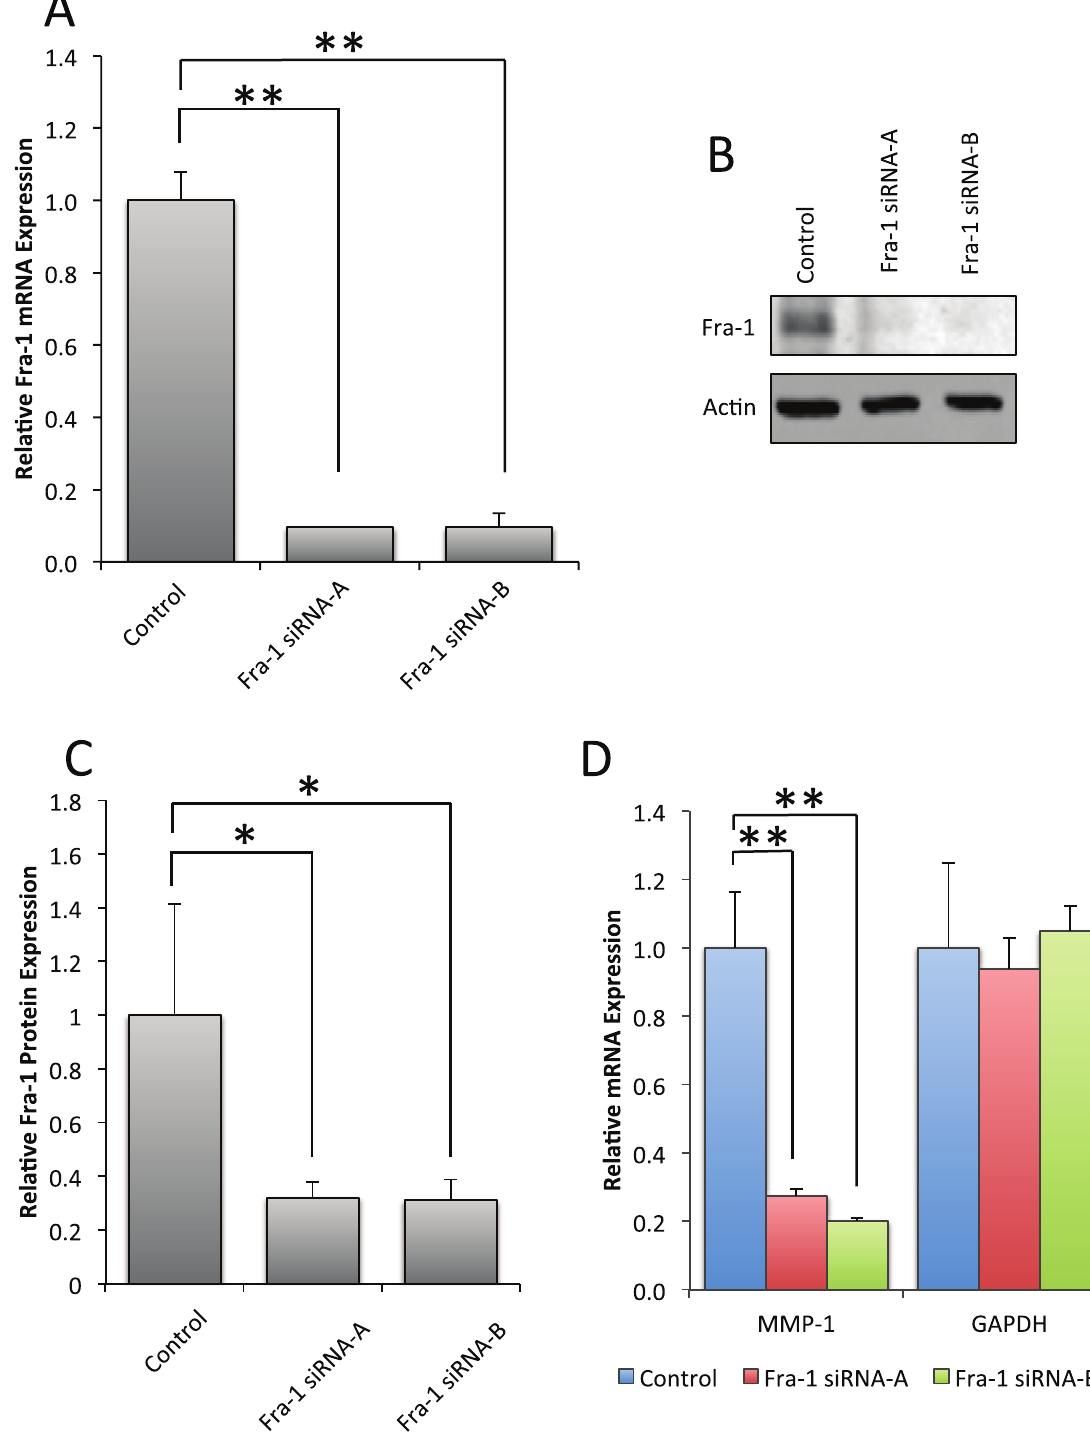
Figure 5. Fra-1 is required for MMP-1 mRNA expression in Scp-2 cells. A ) Scp-2 cells were transfected with control or two independent siRNA duplexes for Fra-1. Fra-1 mRNA levels were measured by qPCR. B ) Scp-2 cells transfected with control or Fra-1 siRNA duplexes were immunoblotted with anti-Fra-1 antibodies. Anti-actin antibody served as a loading control. C ) Mean Fra-1 band intensity from immunoblots as in ( B ) from three independent experiments. D ) qPCR of MMP-1 and GAPDH control mRNA expression of Scp-2 cells transfected with control or Fra-1 siRNA duplexes. In A , C and D , mean relative values are shown +/- standard deviation from three independent experiments. *, p < 0.05; **, p < 0.005 for two-tailed t-tests.